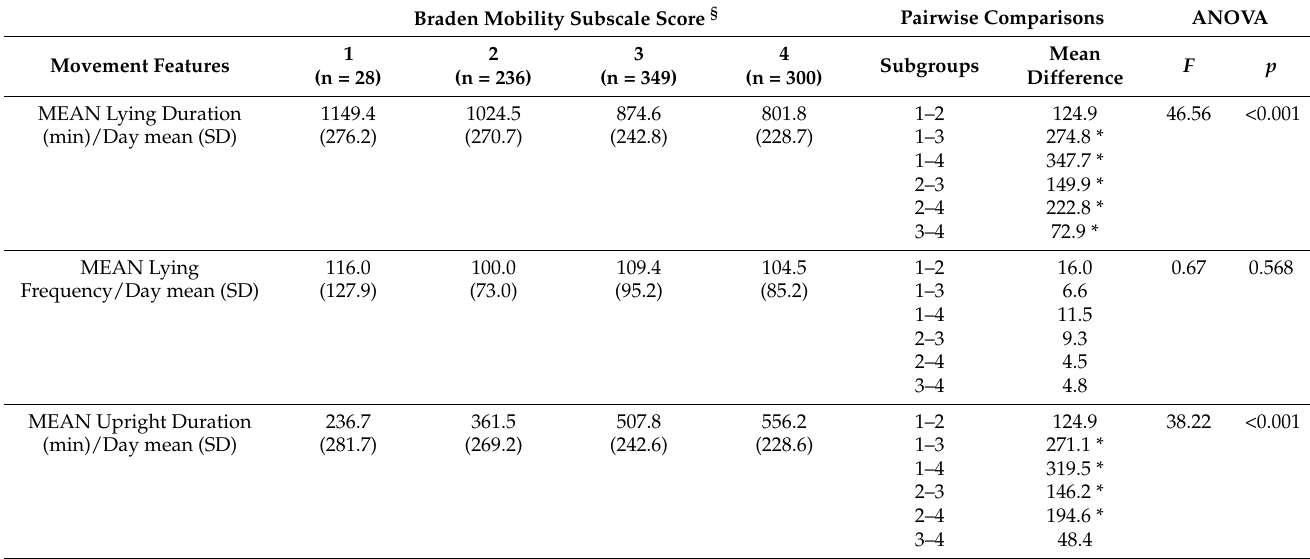
Table 2. Examining Mean Differences Between Braden Mobility Subscale Score Groups Relative to Movement Features (N =